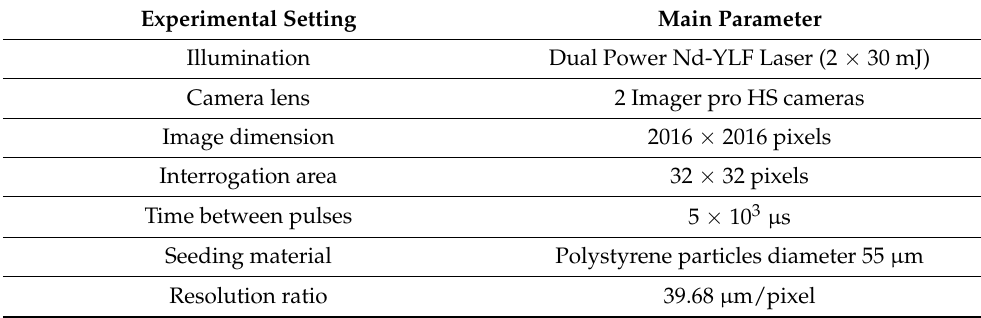
Table 1. Experimental settings for PIV